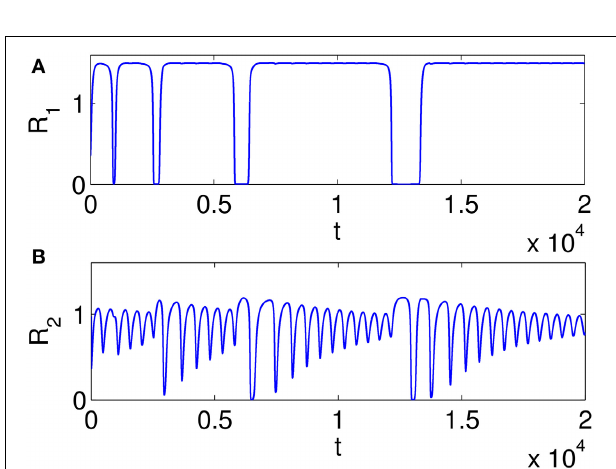
FIGURE 7 | Examples of time series illustrating heteroclinic chimera in a GLV network with degraded inhibitor weights; the GLV network has 6 units, and two units are shown here. (A) Variable R 1 ( t ) exhibits SHC regime with stable values over extended time periods; (B) Variable R 2 ( t ) has frequent irregular oscillations; the determined positive Lyapunov exponent indicates the existence of chaos.